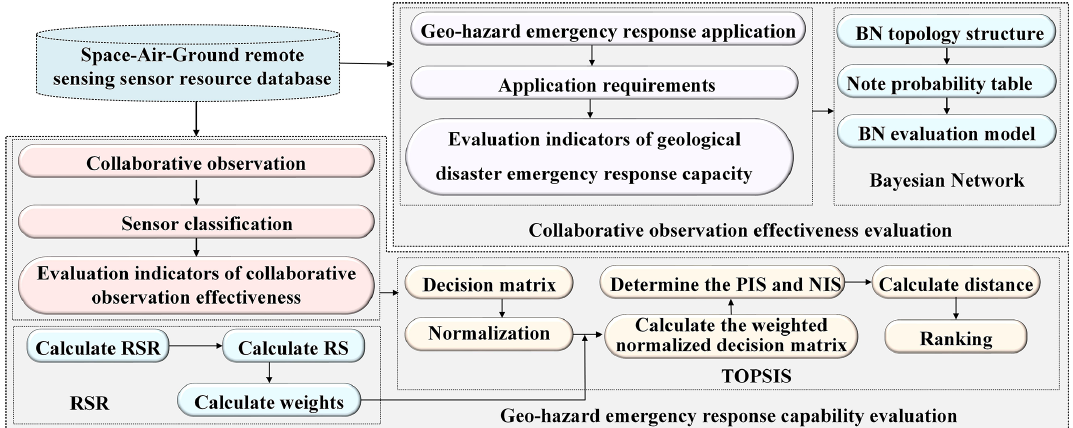
Figure 5. Evaluation